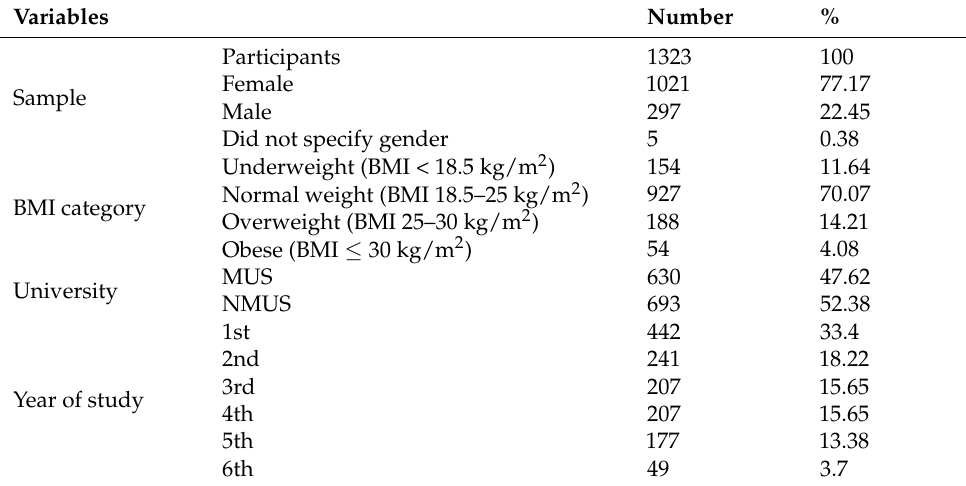
Table 1. Demographic characteristics of participants.